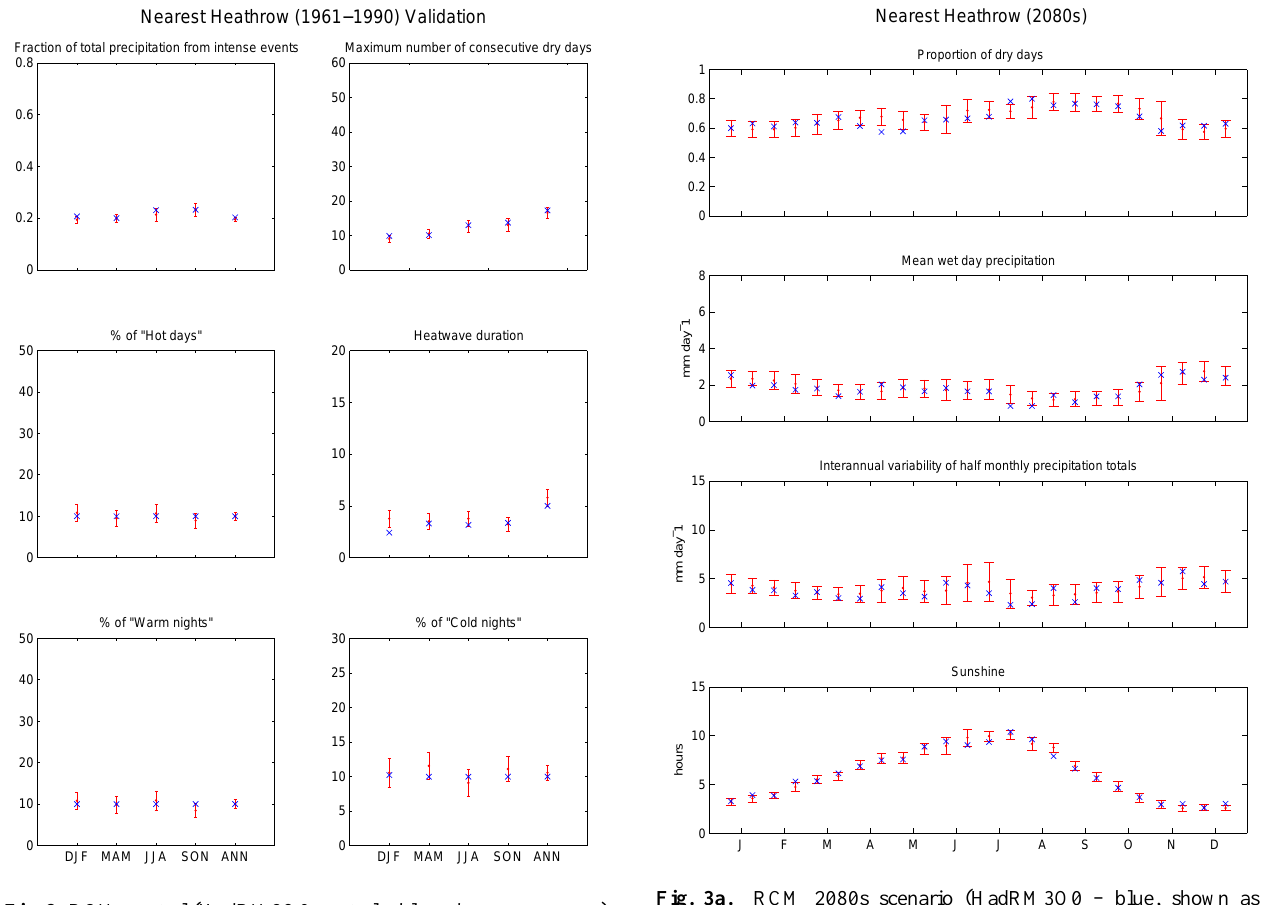
Fig. 2. RCM control (HadRM3Q0 control – blue, shown as crosses) and simulated (red dots and error bars) extremes for each half month mean for the grid cell nearest Heathrow based on a 30yr period (1961–1990). The simulated values are the means of 100 weather generator runs. The lines and bars show the variability of the 100 runs (plotted as plus/minus two standard deviations around the mean).